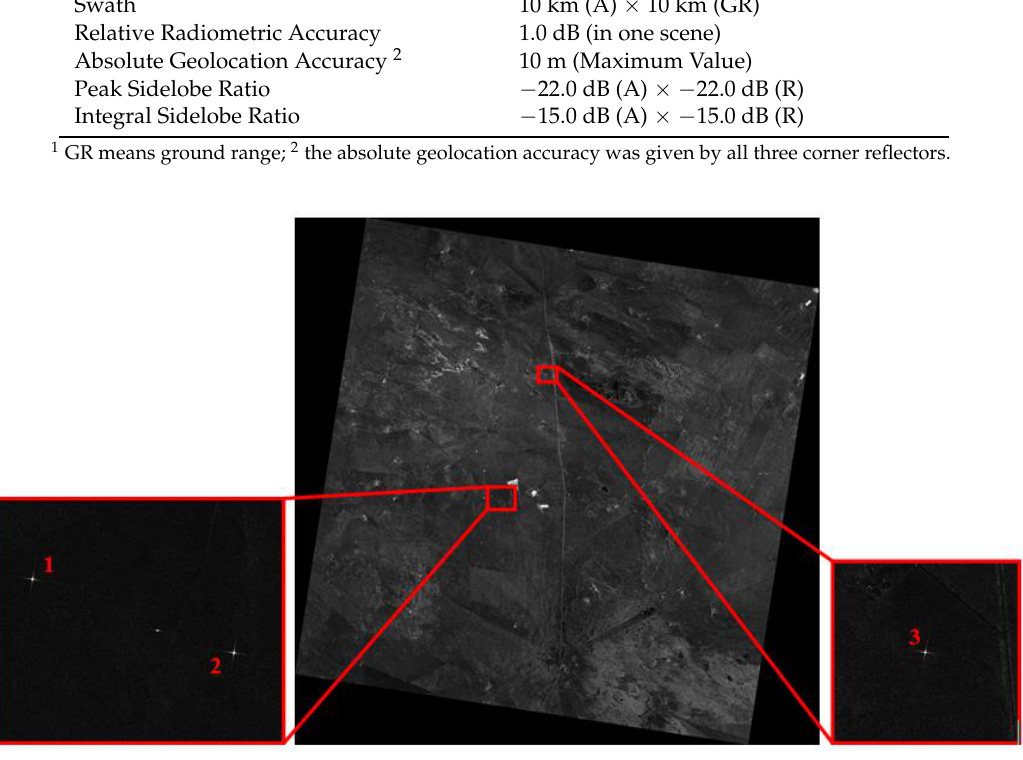
Figure 6. Geocoded product imagery of the performance test site for spotlight mode of GF-3 (The number 1, 2 and 3 indicate the positions of the corner reflectors). number 1, 2 and 3 indicate the positions of the corner